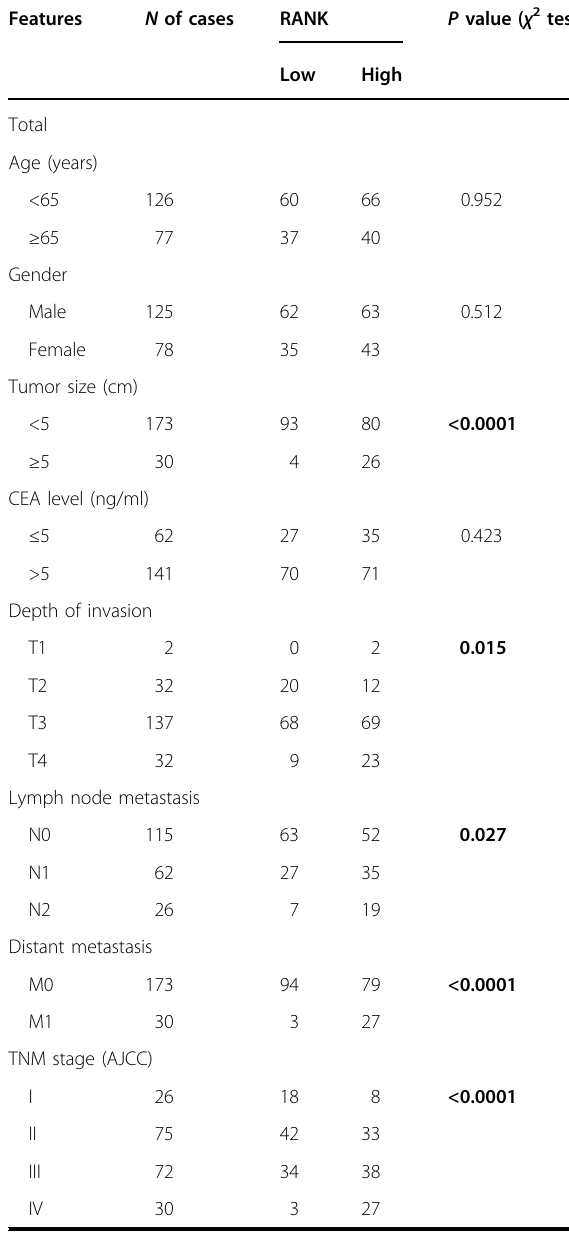
Table 1 Correlation between RANK expression and clinicopathologic features of 203 CRC patients.